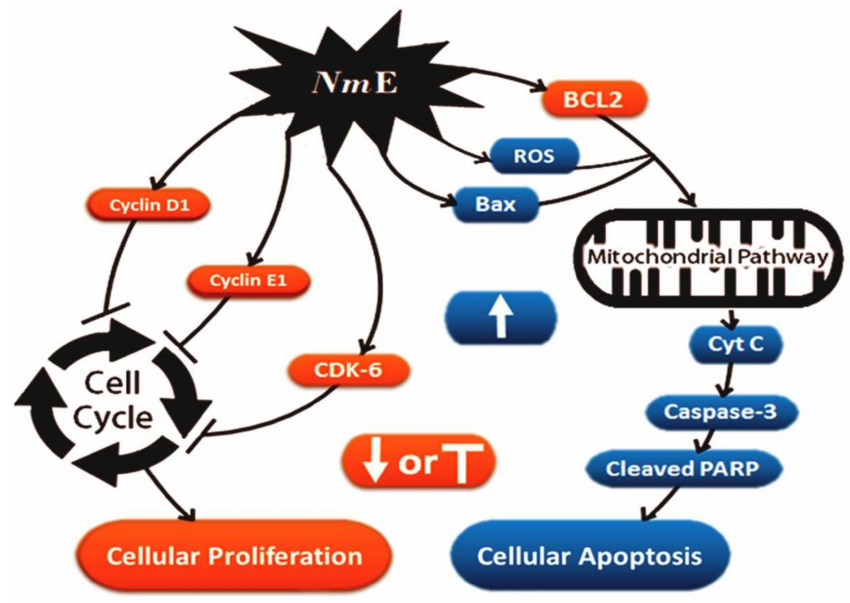
Figure 13. Schematic drawing of the mechanism of action of Nm E. This carton is based on the current available data throughout 474 the present